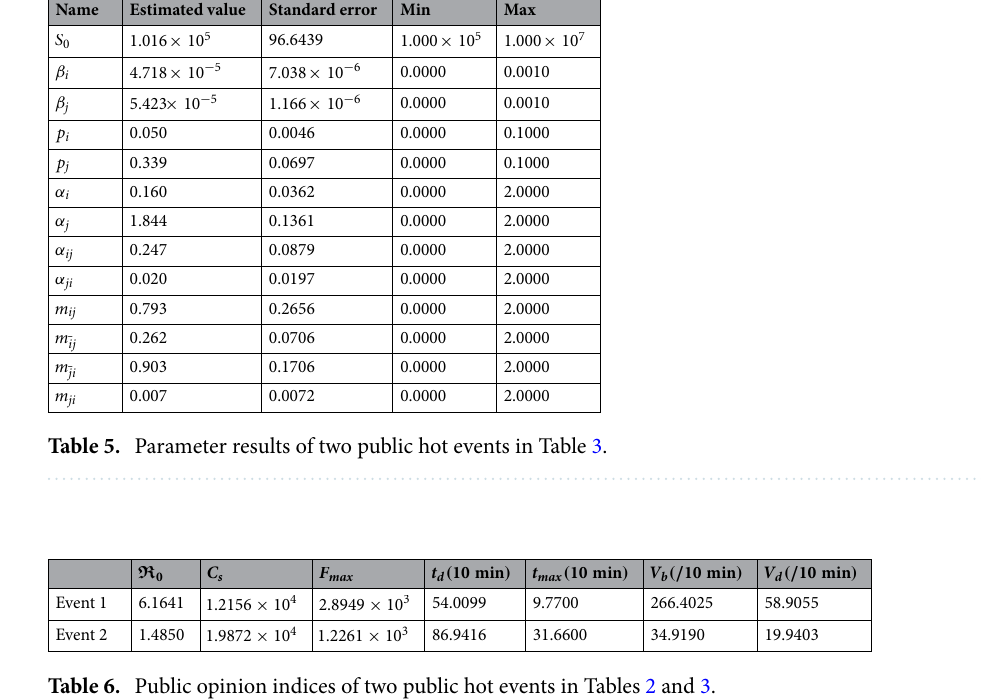
Table 6. Public opinion indices of two public hot events in Tables 2 and